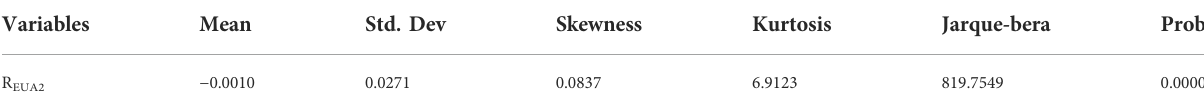
TABLE 14 Phase II data descriptive statistics. This table presents the descriptive statistics results of carbon price returns considered for the whole sample period. JB denotes the Jarque-Bera test statistic for the null of normality. Variables